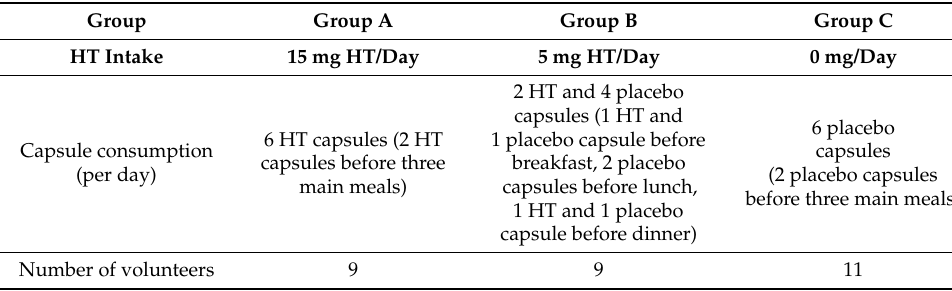
Table 1. Description of intervention groups. Each hydroxytyrosol (HT) capsule contained 2.5 mg of HT. For each group, the total HT intake and capsule consumption per day is illustrated. In the last row, the number of volunteers of each group is